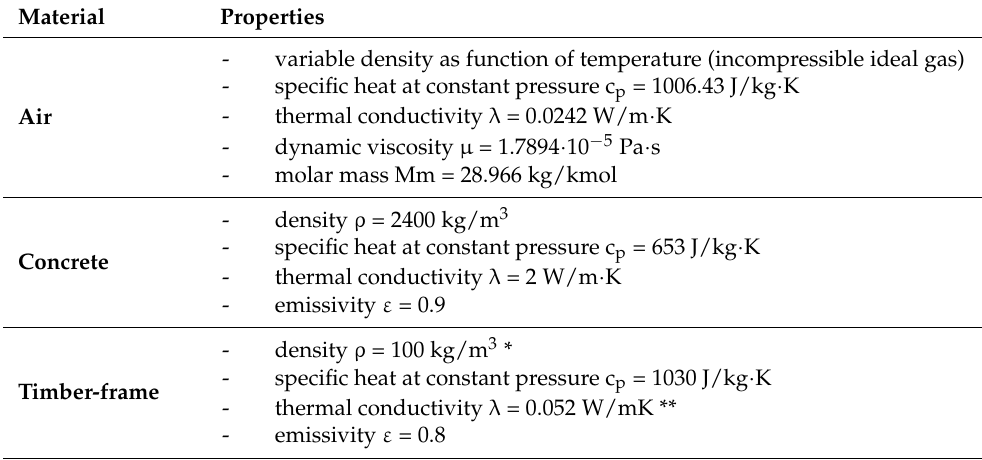
Table A2. Material properties considered for the model.